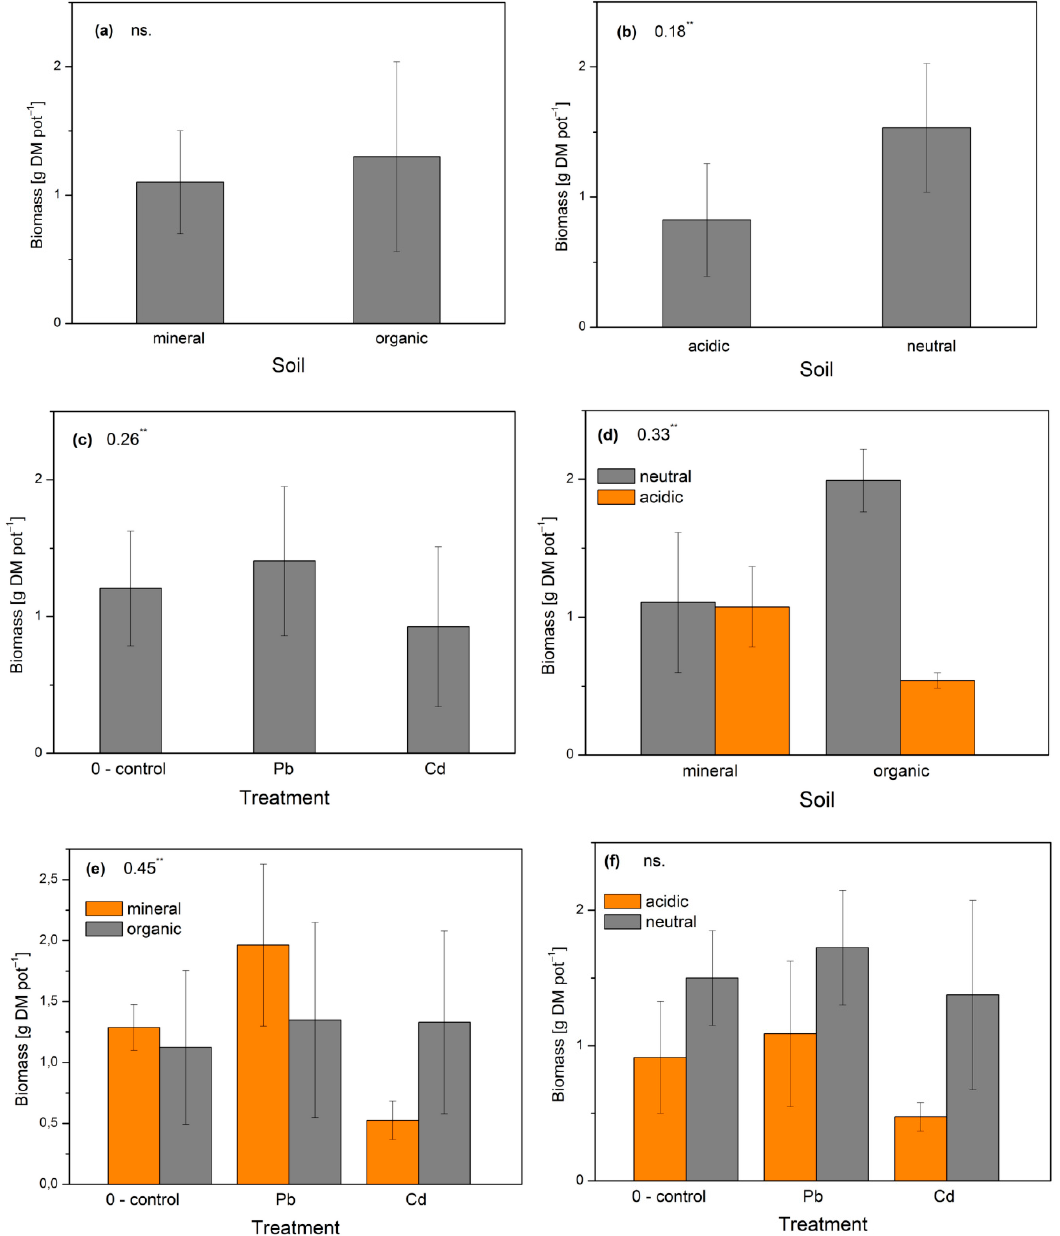
Figure 2. Mean underground biomass of Fagopyrum esculentum (g DM pot − 1 ). ( a – f )—sequence of subfigures. LSD p = 0.01 **, ns.: non-significant (A, soil; B, soil reaction; C, metal; AB, soil, soil reaction; AC, soil, metal; BC, soil reaction, metal). A ns., B 0.18 **, C 0.26 **, AB 0.33 **, AC 0.45 **, BC